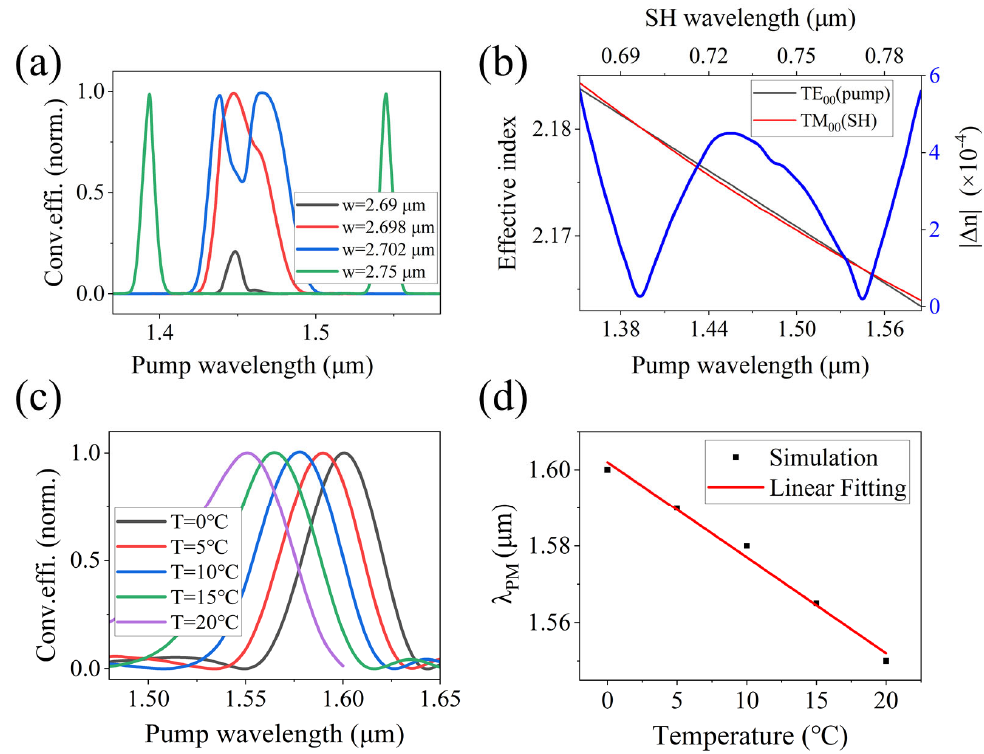
Figure 3. ( a ) The conversion efficiency spectra with the waveguide length of L = 5 mm at 20 ◦ C. ( b ) Curves of the effective refractive index and the index difference between the TE 00 mode at 1.55 µ m and the TM 00 mode at 0.775 µ m, as a function of pump wavelength. ( c ) Conversion efficiency spectra at different temperatures, when w = 2.71 µ m, h = 2 µ m ( L = 5 mm). ( d ) The temperature dependence of the MPM wavelength.